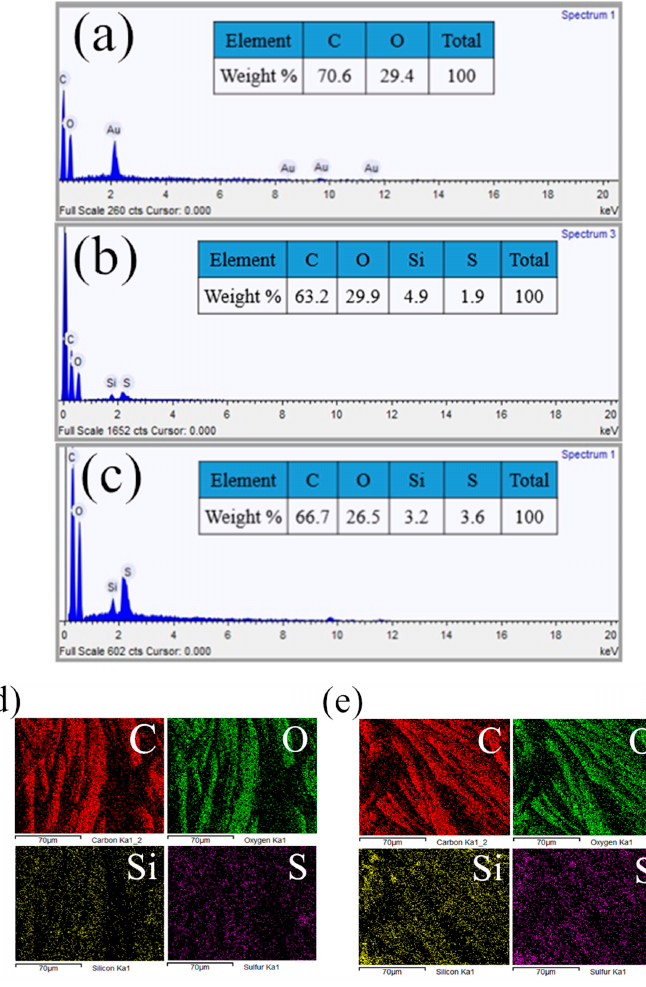
Coatings 2020 , 10 , x FOR PEER REVIEW 7 of 13 new peak at 284.9 eV can be observed, corresponding to C–Si bonds. After the click reaction, the S 2 p , S 2 s , and C 1 s peaks were significantly enhanced (Figure 5a). Furthermore, the C–Si peak of bonds. Figure 4. EDS spectrum of the ( a ) original fabric, ( b ) fabric-SH, ( c ) superhydrophobic fabric, ( d ) element mapping of fabric-SH, ( e ) EDS mapping images of the superhydrophobic fabric surfaces. The original cotton fabric, fabric-SH and finished fabric were measured using X-ray photoelectron spectroscopy (XPS). On the surface of the original fabric, only C and O elements were found. On the surface of the mercapto cotton, observation of the four elements Si, C, O, and S (Figure 5a) showed that MPTES was successfully grafted onto the fiber. In Figure 5b, the C 1 s peak of the original fabric shows three different peaks at approximately 284.6 eV, 286.4 eV, and 288.2 eV, which are attributed to C–C or C–H, C–O, and C=O bonds [39,40], respectively. As shown in Figure 5c,d, a